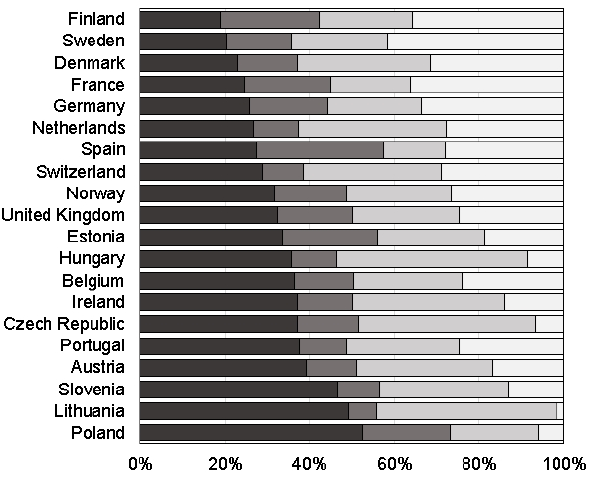
Figure 4. Clusters’ population distribution, by country.